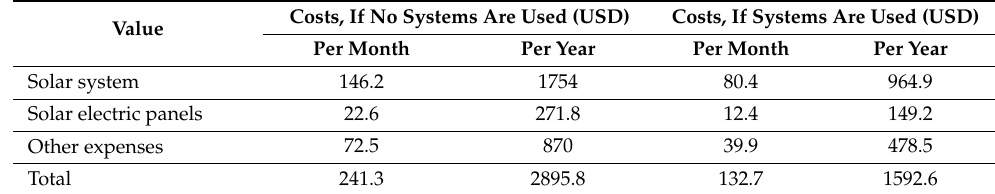
Table 9. Comparison of the cost of alternative